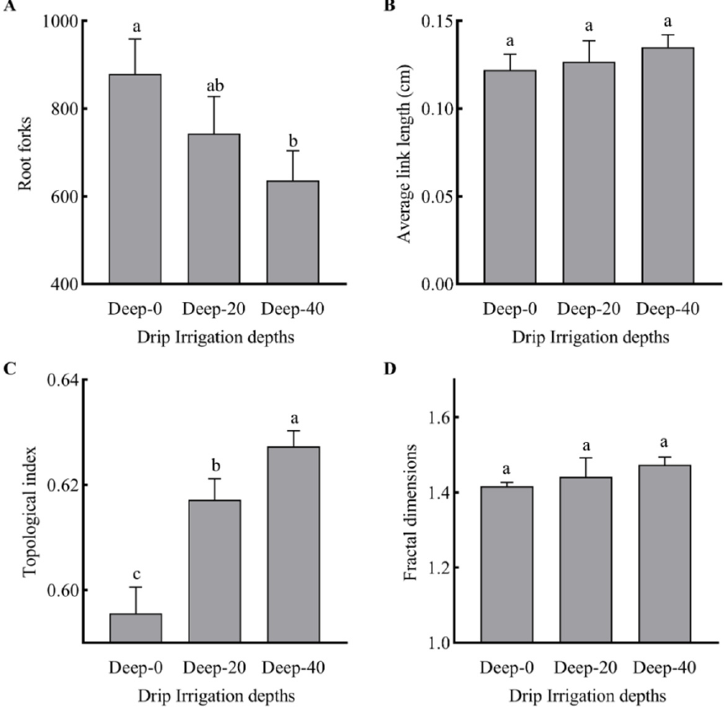
Figure 6. Root system architecture of alfalfa plants under three drip irrigation depths. ( A ) Number of root forks, ( B ) average link length, ( C ) topological index, and ( D ) fractal dimension. Lower-case letters above bars indicate a significant difference ( p < 0.05, LSD test).